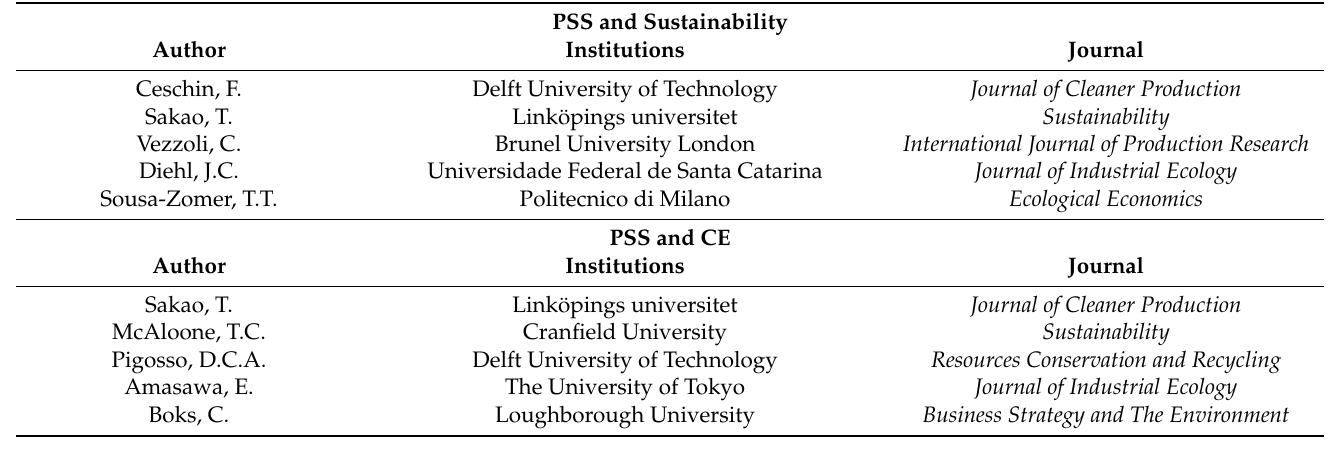
Table 13. Main characteristics for CE and Sustainability research.